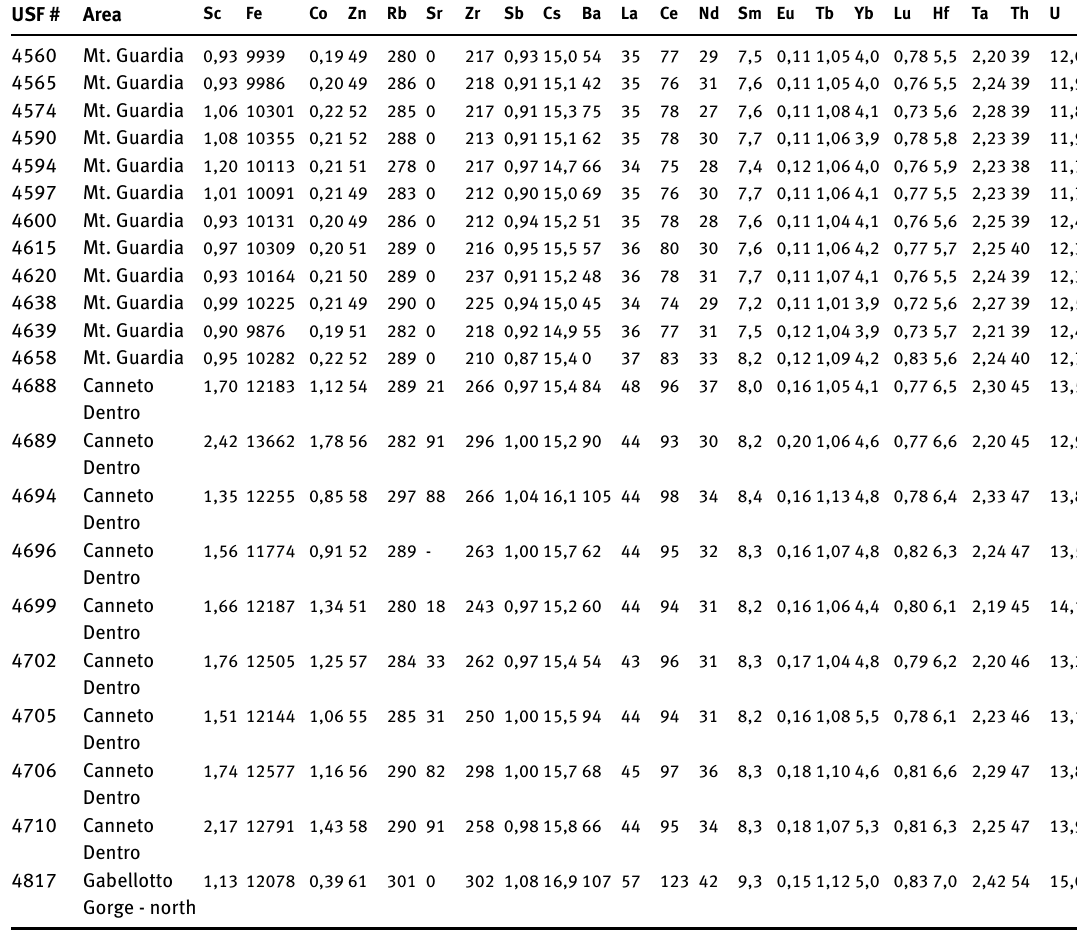
Table 1. INAA analyses of Lipari